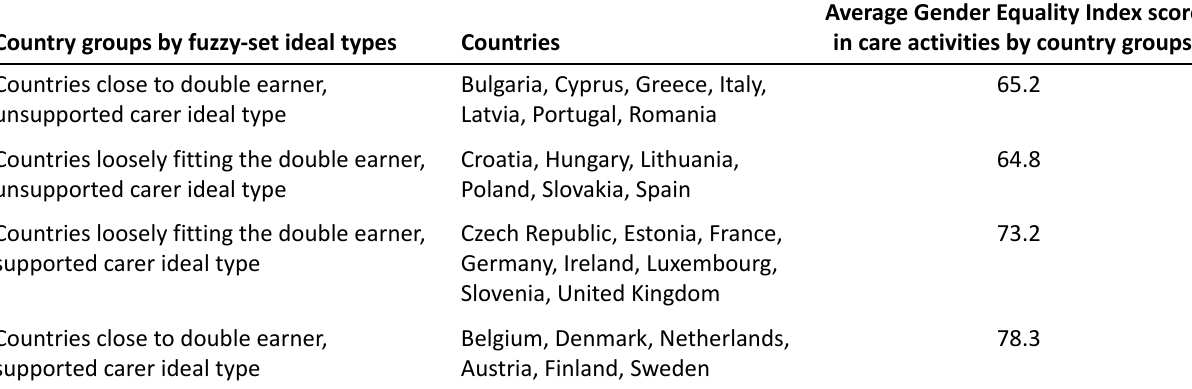
Table 5. Gender equality scores by ideal